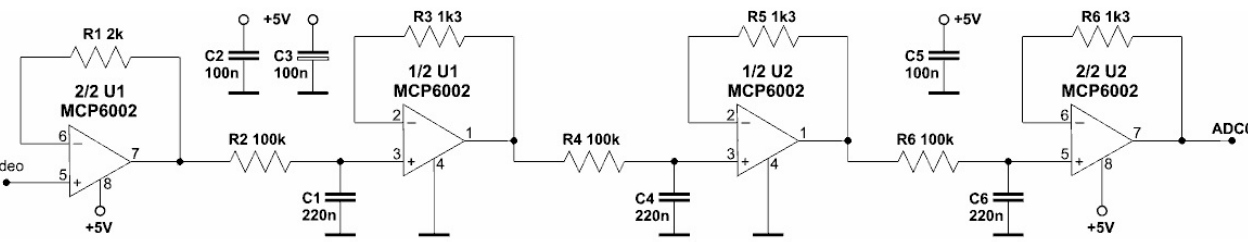
Figure 17. Low-pass filter schematic used in the measurement circuit.